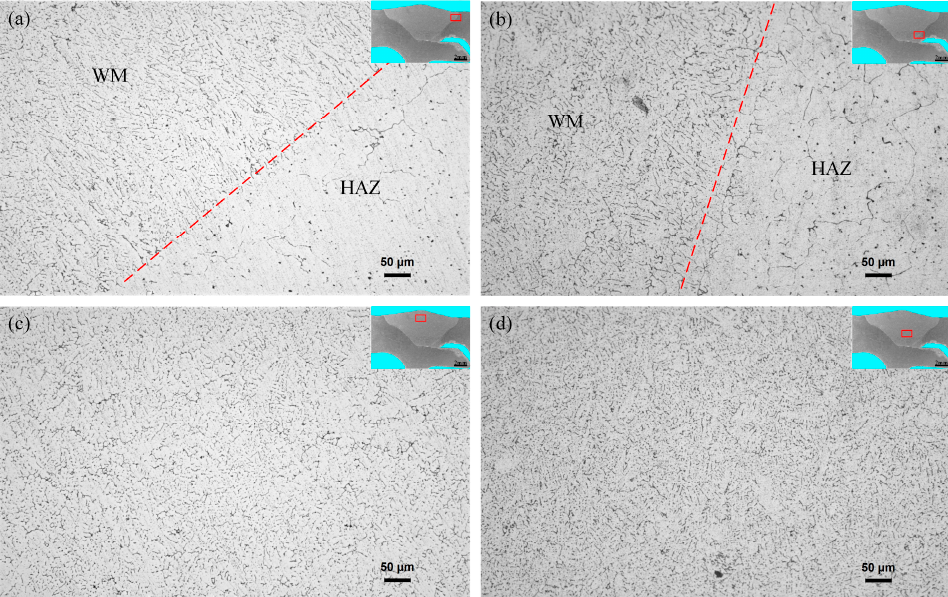
Figure 5. Microstructure of the joints: ( a ) near the fusion line of the arc-affected zone; ( b ) near the fusion line of the laser-affected zone; ( c ) weld center of the arc-affected zone; and ( d ) weld center of the laser-affected zone.